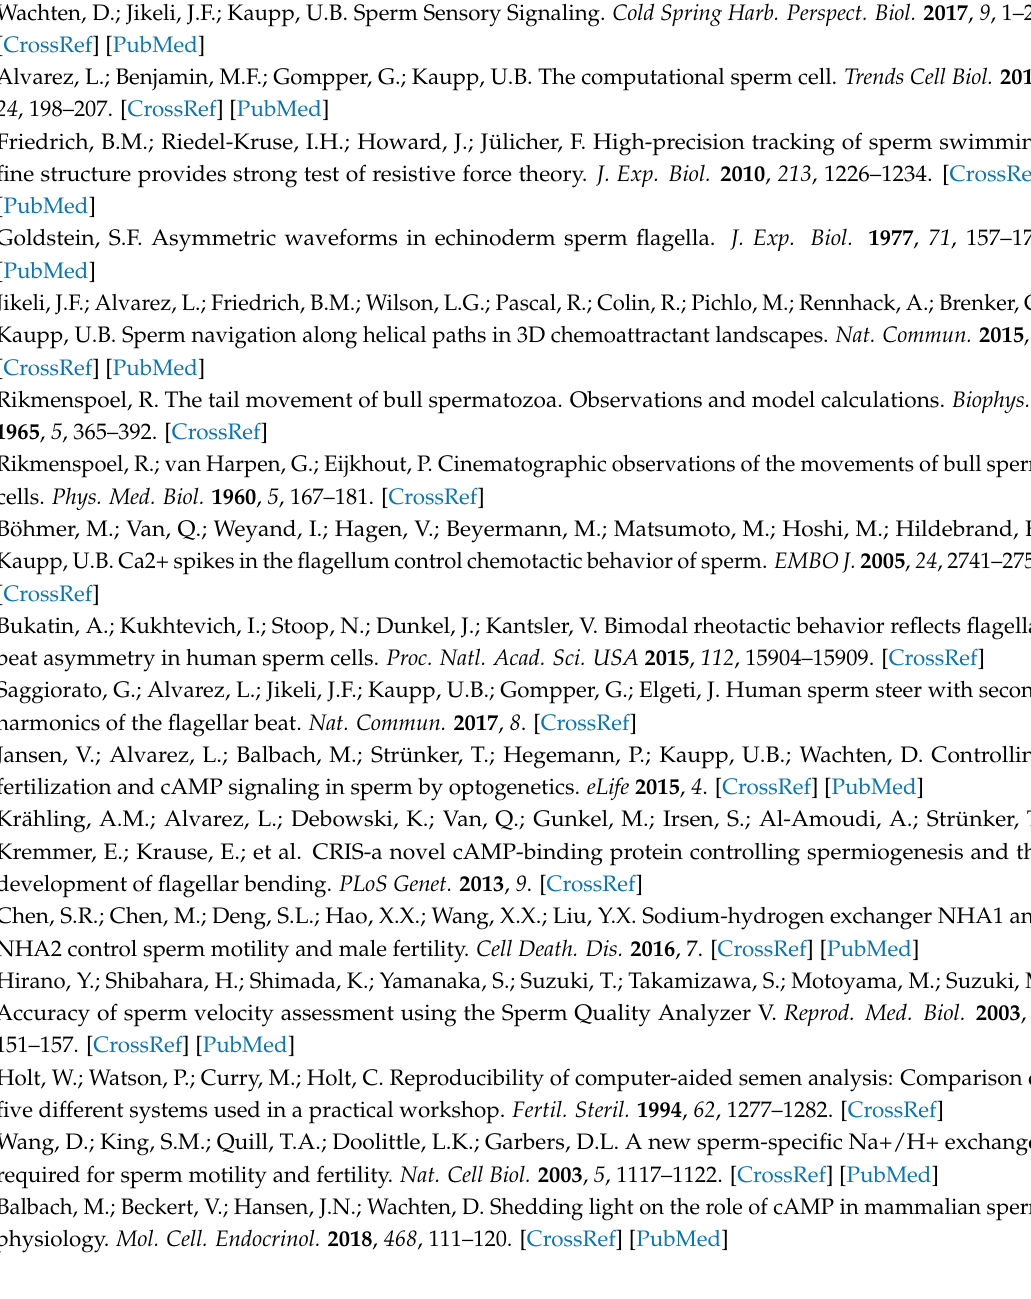
Figure S1: Exemplary output file generated by SpermQ Evaluator for a head-tethered mouse sperm; Figure S2: Exemplary output file generated by SpermQ Evaluator for a head-tethered mouse